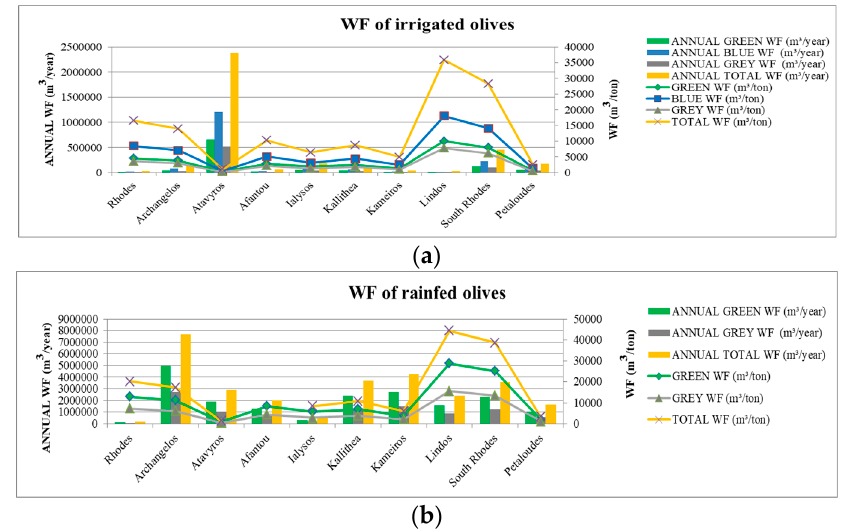
Figure 6. WF (m 3 t − 1 and m 3 year − 1 ) per MU of ( a ) irrigated olives and ( b ) rainfed olives.